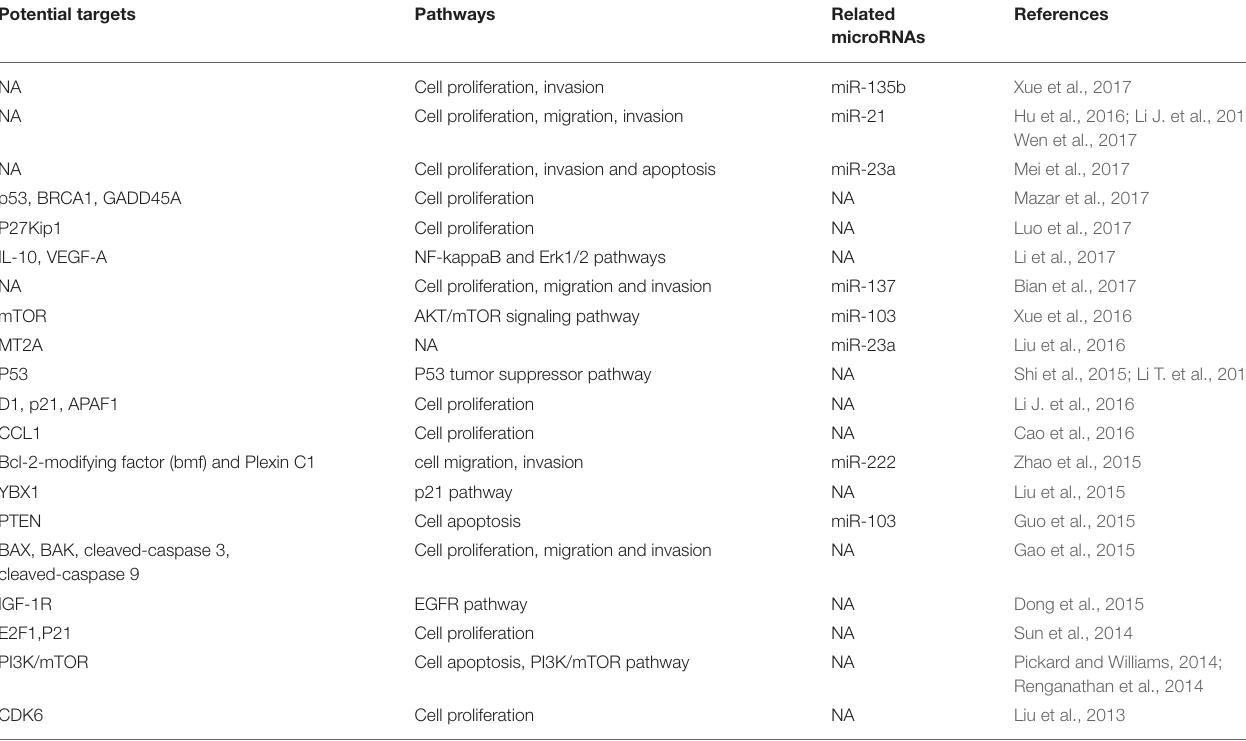
TABLE 4 | Summary of GAS5 with their potential targets, pathways and related microRNAs